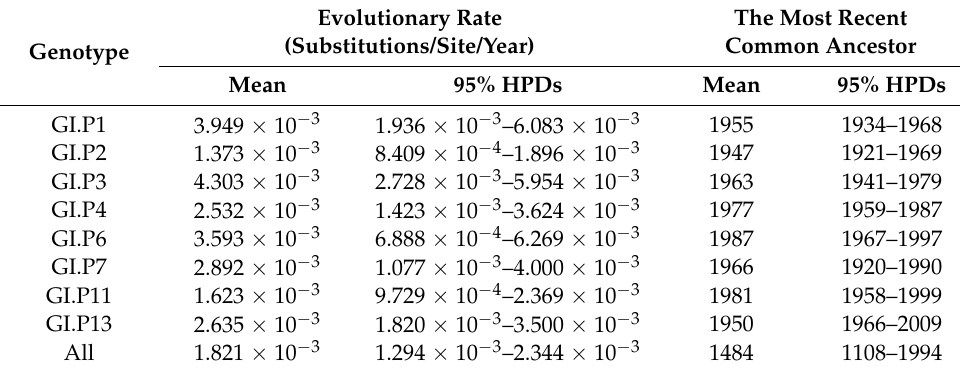
Table 2. Evolutionary parameters of norovirus GI RdRp